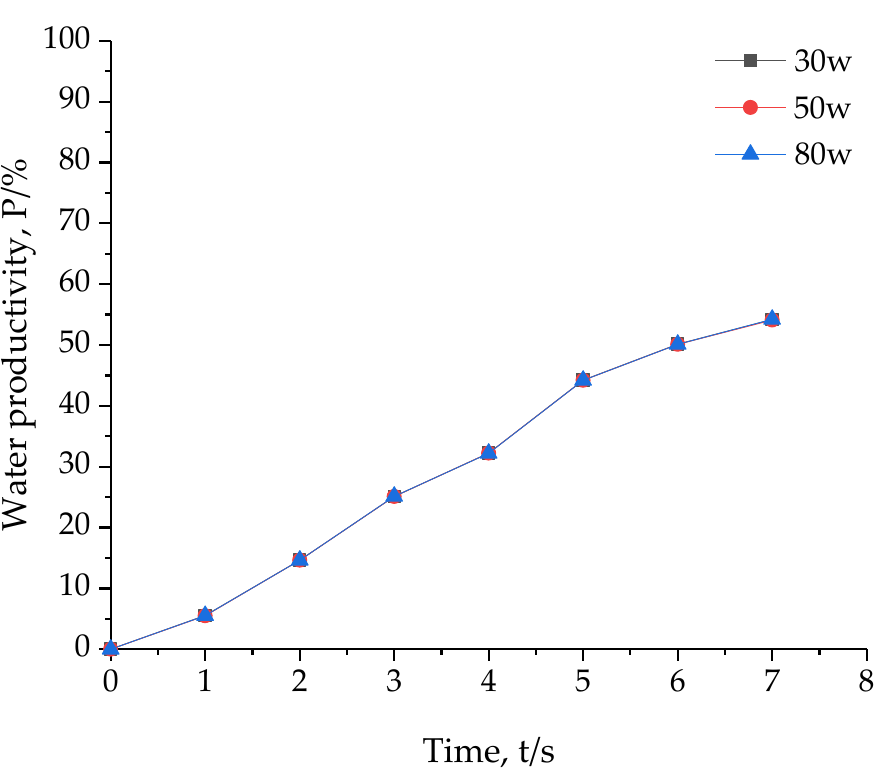
Figure 5. Curve of water productivity rising with time under different grid numbers.